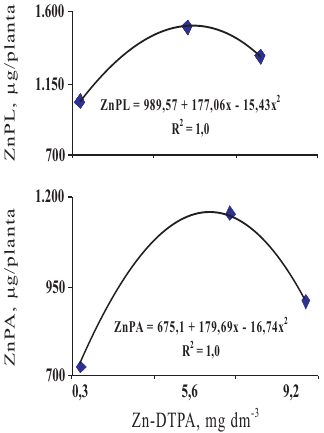
Figura 1. Conteúdo de zinco na planta inteira (Zn–PL) ou na parte aérea (Zn–PA) em função do teor disponível no solo pelo extrator DTPA, na espécie C. arabica